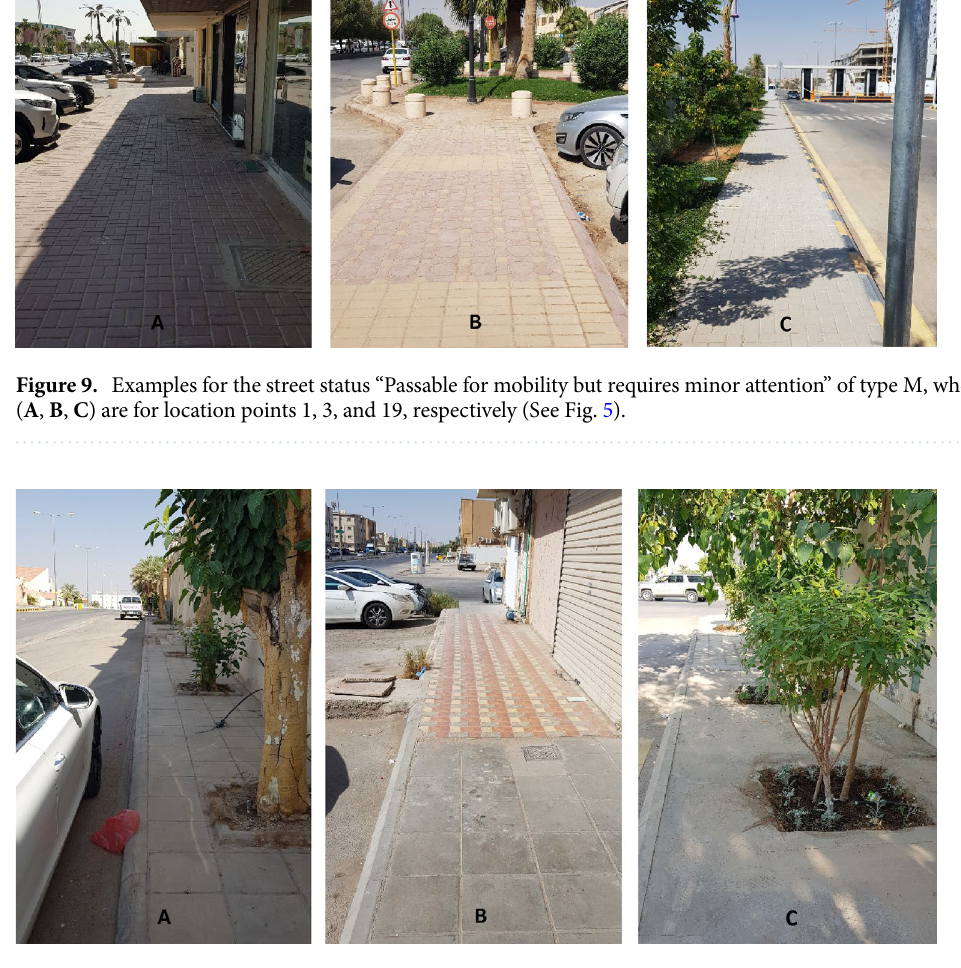
Figure 10. Examples for the street status “insufficient for mobility and requires some attention” of type M, where ( A , B , C ) are for location points 10, 15, and 18, respectively (See Fig.